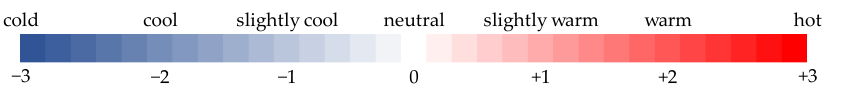
Figure 14. PMV Scale.